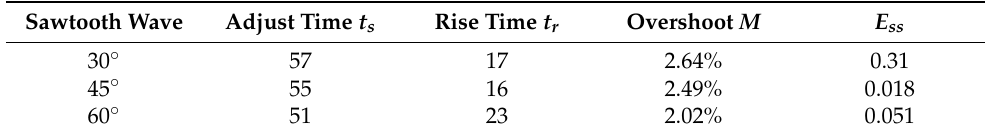
Table 3. Performance in learning sample of sawtooth wave.